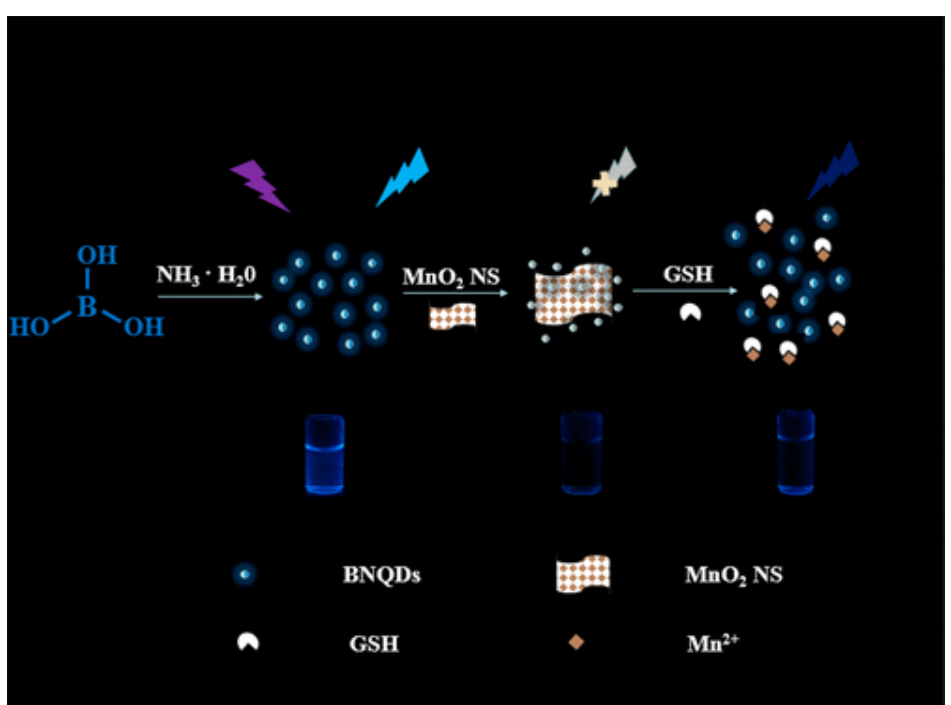
Figure 10. Schematic principle of glutathione (GSH) regulated IFE (inner filter effect) of MnO 2 NS on BNQDs for sensing. The observed fluorescence of BNQDs is quenched with the MnO 2 NS presence and later recovered with GSH application. Reproduced from [67] with permission from copyright © 2019 American Chemical Society.